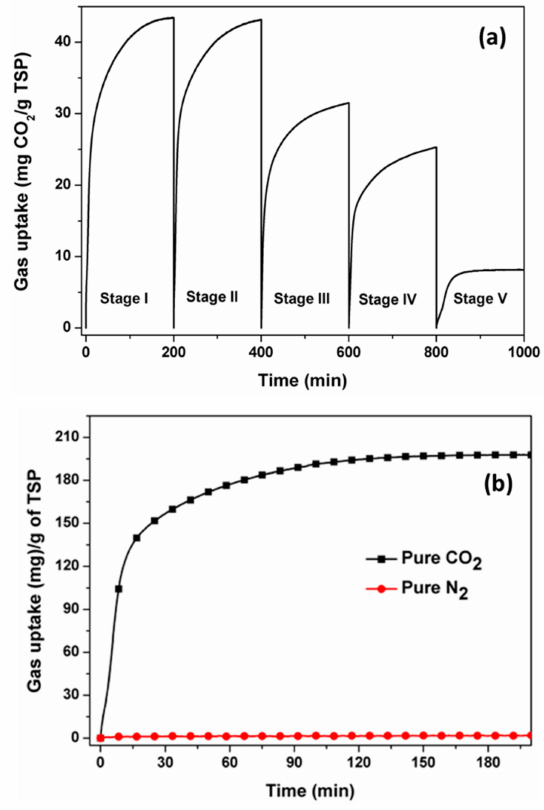
Figure 6. ( a ) CO 2 uptake capacity for flue gas mixture contains16.1% CO 2 at 30 ◦ C temperature and 3.5 MPa pressure in five di ff erent stages; ( b ) the selectivity of pure CO 2 over pure N 2 gas at 30 ◦ C temperature and 3.5 MPa pressure (Curves provided to guide the